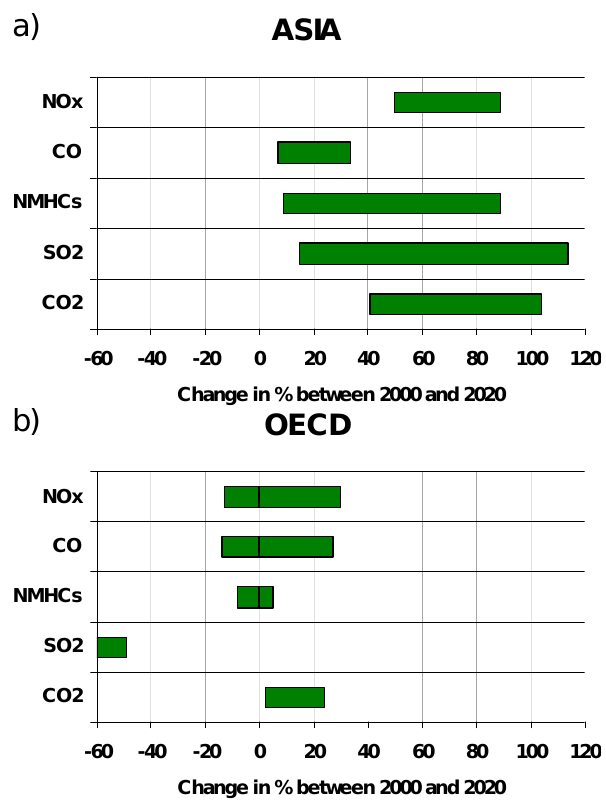
Fig. 3. Expected increases in trace gas emissions during the period 2000–2020 for (a) Asia and (b) the OECD nations (Based on data published in IPCC Emission Scenarios 2000 , http://www.ipcc.ch/